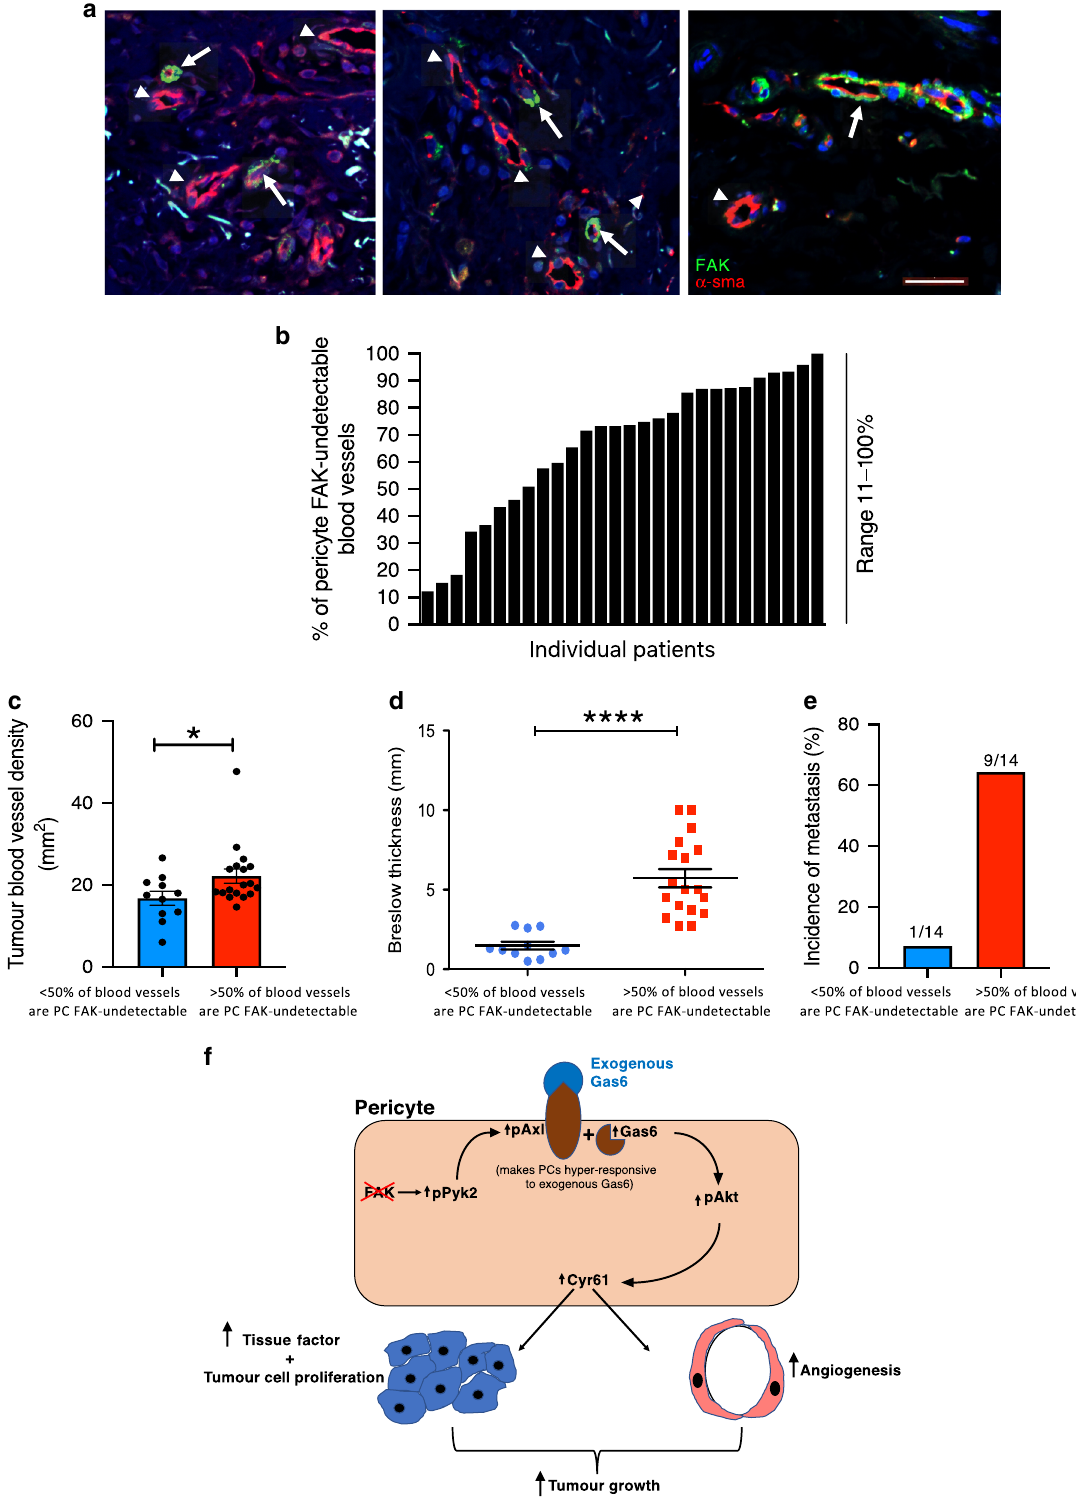
endothelial mitogen (Generon) to passage 4 – 5. Brie fl y, for pericytes, brains were removed from mice, minced, digested for 1h in 0.1% collagenase, centrifuged in the presence of 22% BSA, and cultured in endothelial cell growth media (pMLEC) with the medium changed every 3 days. On reaching con fl uency, cultures were harvested with trypsin and passaged. During the fi rst two passages, pericyte cul- tures were grown in pMLEC, and on the third passage they were grown in pericyte medium (PM; ScienCell Research Laboratories) containing 2% FBS and